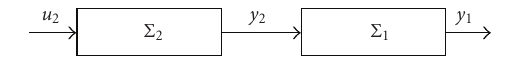
Figure 1: Cascade interconnection of two dynamical